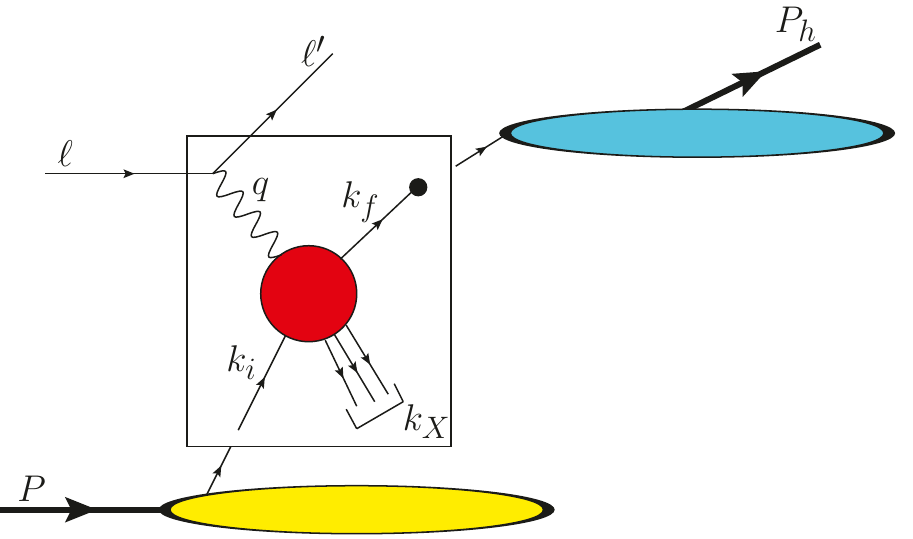
Figure 1 . Sketch of the SIDIS process, with scattering of an incident lepton (momentum ‘ ) via the exchange of a virtual photon ( q ) from a parton ( k ) inside a nucleon ( P ), with the scattered parton i ( k ) fragmenting to a hadron ( P ) in the final state and unmeasured hadronic debris ( k ). The f h X lower (yellow) blob represents the residual system after removal of the parton from the incoming nucleon, while the upper right (cyan) blob represents the fragmentation of the outgoing parton into the observed hadron. The rectangle envelopes the parton level subprocess, and the arrows represent momentum flow. The black dot indicates the parton associated with the observed